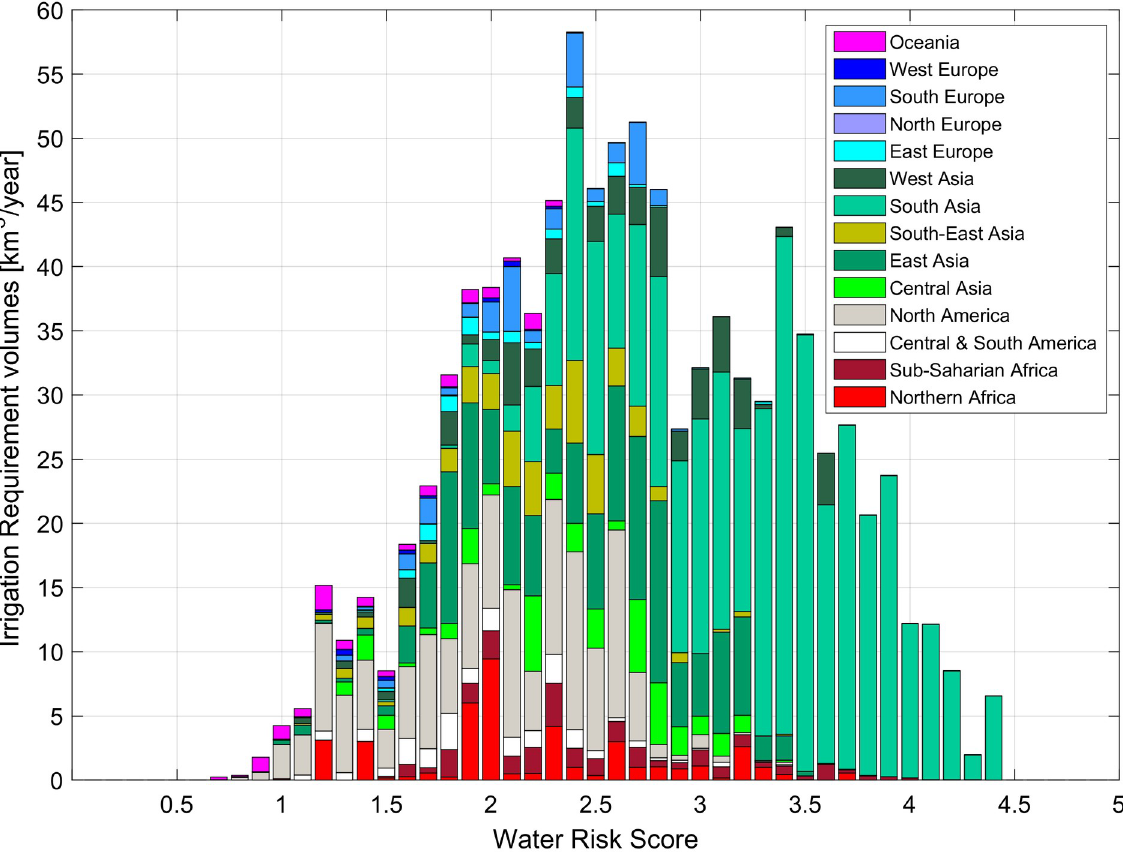
Fig 6. Distribution of irrigation requirement volumes by classes of agricultural water risk. Classification of the World Resources Institute: Low risk (0–1), Low-Medium risk (1–2), Medium-High risk (2–3), High risk (3–4), Extremely High risk (4–5).